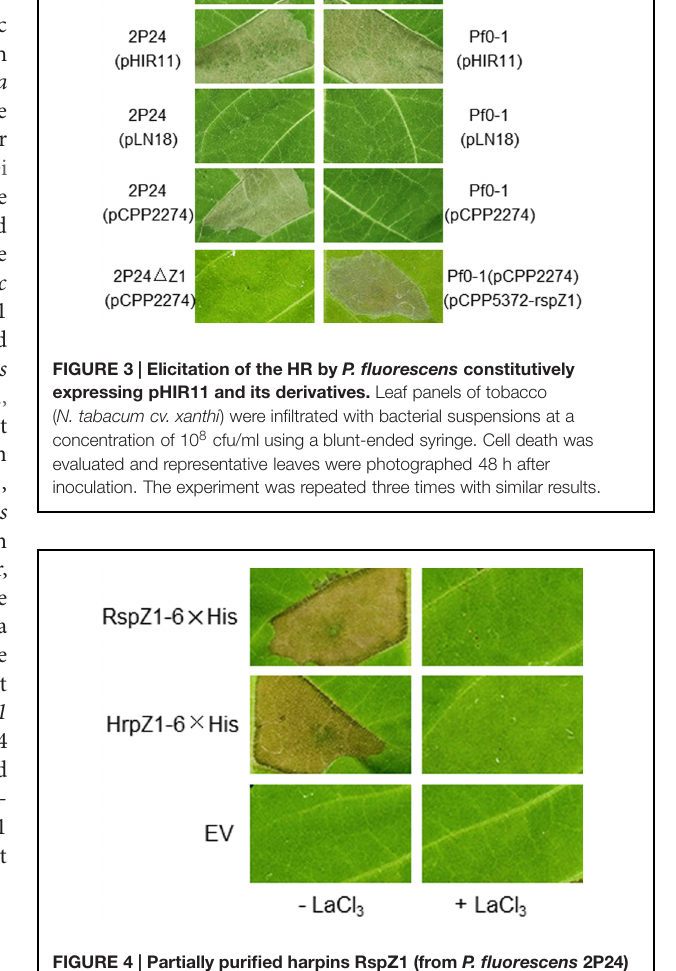
FIGURE 4 | Partially purified harpins RspZ1 (from P. fluorescens 2P24) and HrpZ1 (from P. syringae pv. tomato DC3000) elicit HR-like tissue collapse in tobacco leaves. 6 × His-tagged recombinant protein preparations were diluted in MES buffer and infiltrated into panels of tobacco leaves with or without 2 mM lanthanum chloride, an inhibitor of HR. The presence or absence of confluent cell death was evaluated 24